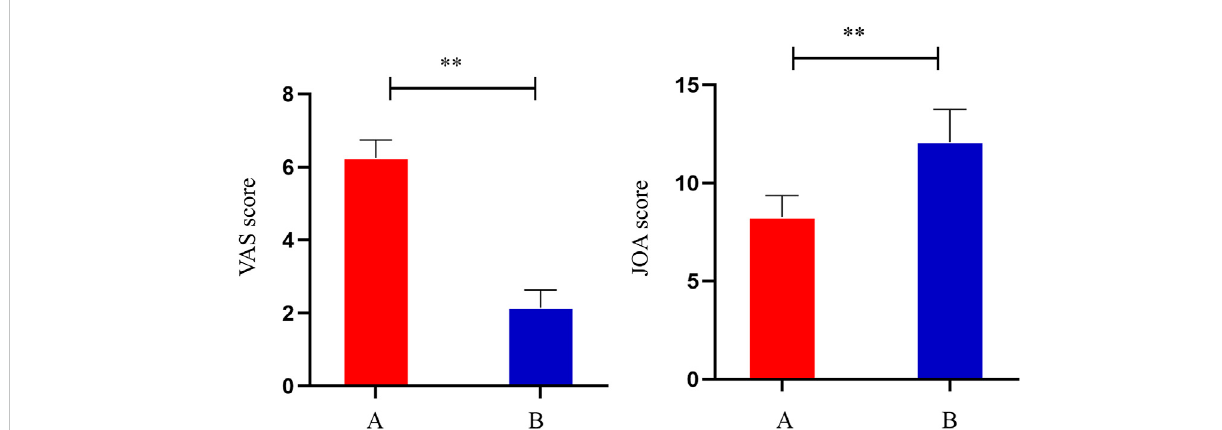
FIGURE 1 VAS scores and JOA scores of patients before and after treatment. **: p < 0.01.